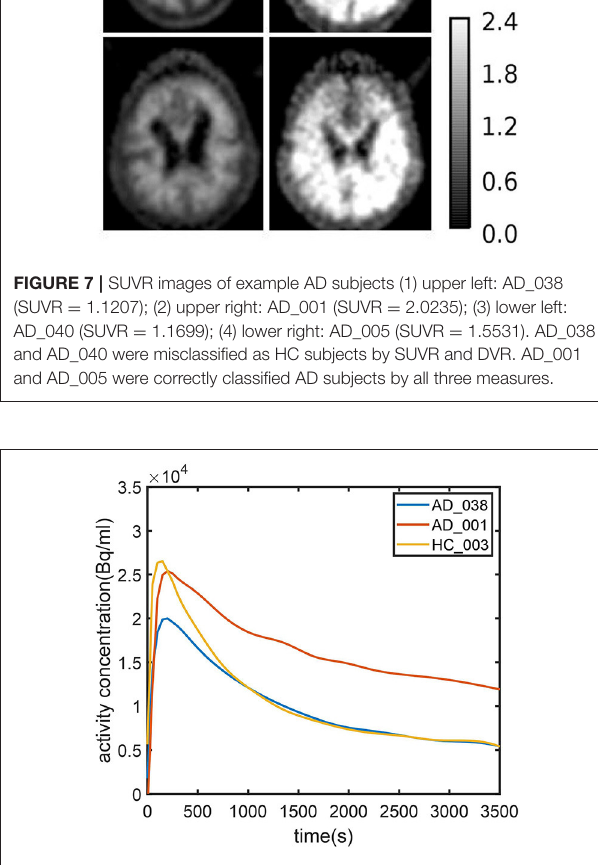
FIGURE 8 | Time–activity curves for (1) typical AD subject (AD_001, blue line) (2) atypical AD subject (AD_038, red line) (3) typical HC subject (HC_003, green line). AD_038 was not identified by SUVR ( Figure 6 ) but was correctly classified by AQI.